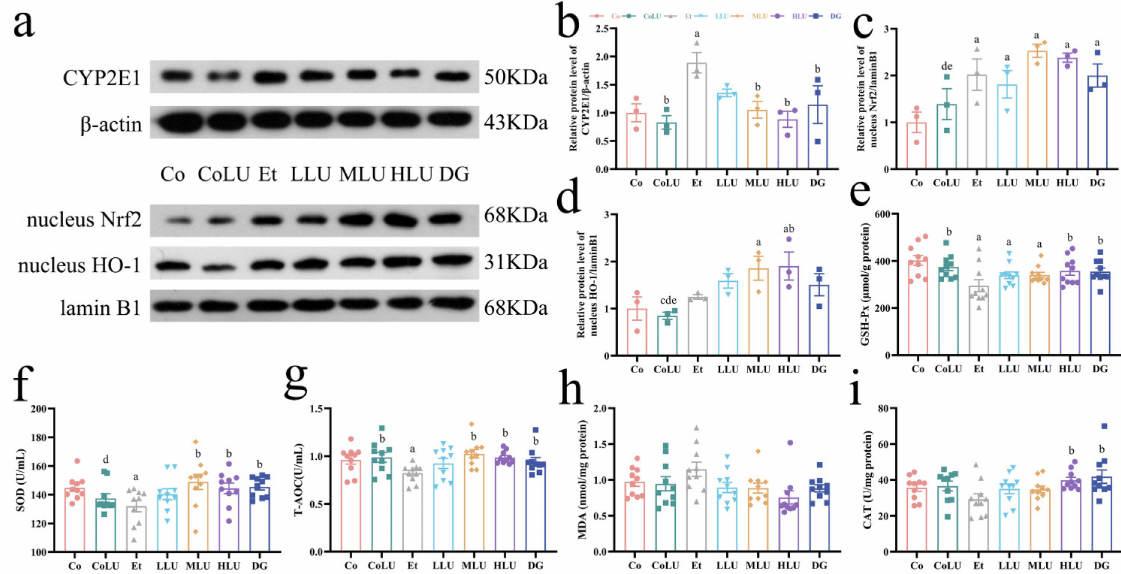
Figure 3. Effect of lutein on oxidative stress in the liver. ( a ) The protein expression levels of CYP2E1 ( b ), nucleus Nrf2 ( c ), and nucleus HO-1 ( d ) ( n = 3/group). Levels of ( e ) Glutathione peroxidase (GSH- Px), ( f ) superoxide dismutase (SOD), ( g ) total antioxidant capacity (T-AOC), ( h ) malondialdehyde (MDA), ( i ) catalase (CAT) ( n = 10/group). The data were shown with mean ± SEM. Co: normal control group; CoLU: the medium-dose lutein control group; Et: ethanol model group; LLU: the low-dose lutein intervention group; MLU: the medium-dose lutein intervention group; HLU: the high-dose lutein intervention group; DG: positive control group. a p < 0.05 vs. Co group, b p < 0.05 vs. Et group, c p < 0.05 vs. LLU group, d p < 0.05 vs. MLU group, e p < 0.05 vs. HLU